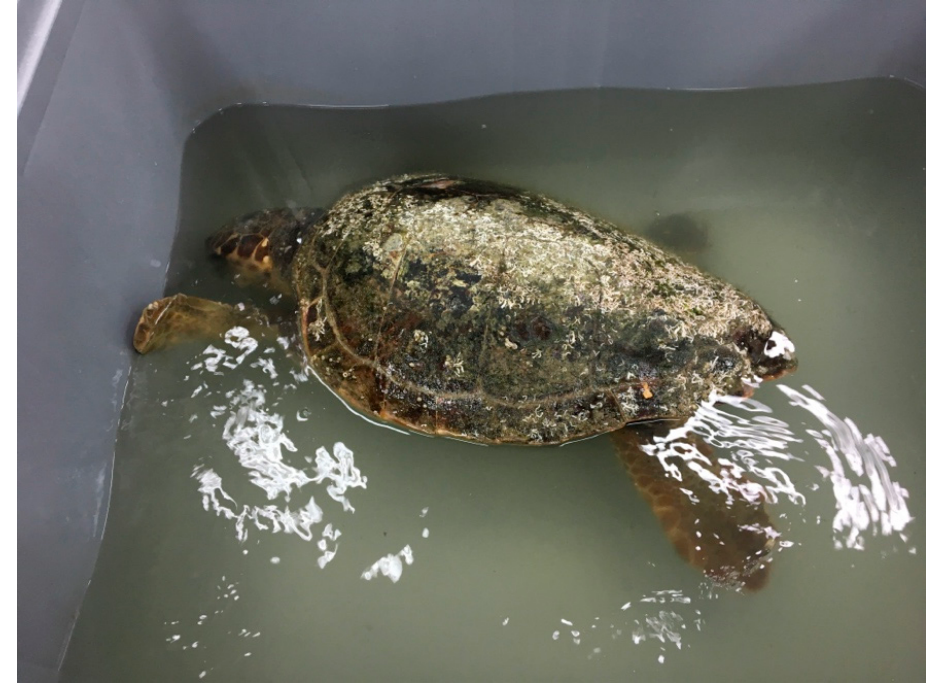
Figure 6. Caretta caretta with buoyancy disorders and difficulty diving.